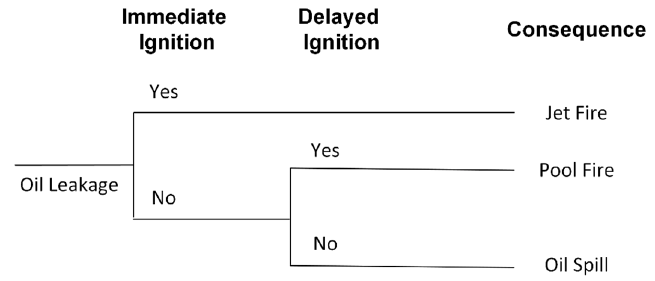
Figure 1. Oil event tree for leakage scenarios. Adapted from [2].